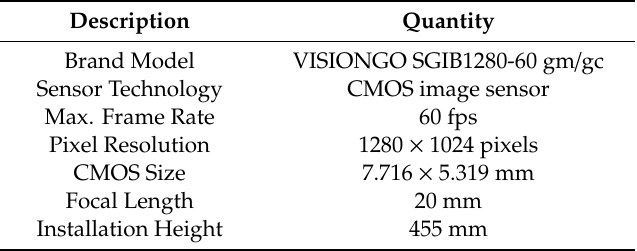
Table 3. Parameters description and values of the cameras used in this